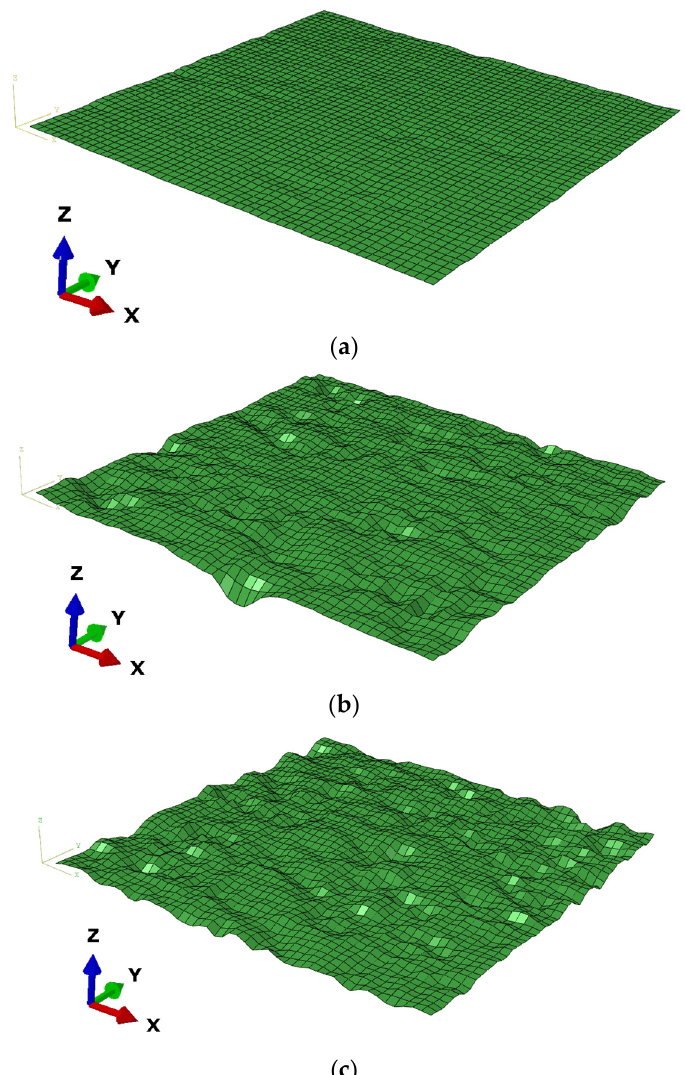
Figure 8. Finite element grid models of asphalt pavements. ( a ) AC pavement ; ( b ) SMA pavement ; ( c ) OGFC pavement .